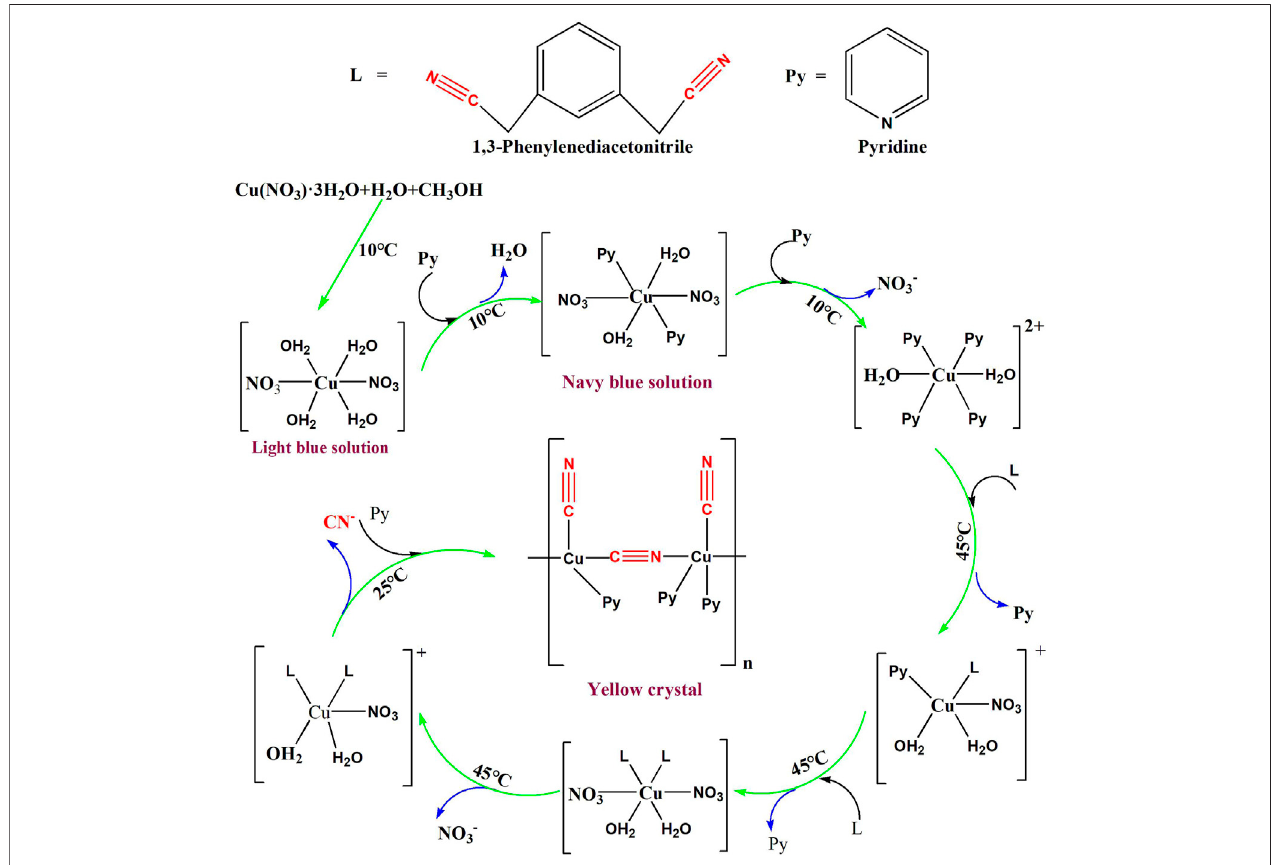
FIGURE 3 | In situ synthesis mechanism of 1 .